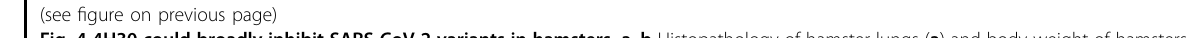
post-inoculation for H&E staining. Scale bar, 100 μ m. c 4H30 showed pre-exposure activity to signi fi cantly inhibit SARS-CoV-2 (B.1.1.63) replication. Intranasal 4H30 (0.5 mg/kg) was administered to hamsters at 24 h ( n = 4), 8 h ( n = 4), 4 h ( n = 6), or before virus challenge (4H30pre, n = 4). Intranasal H23 was administered to hamsters before the virus challenge (H23pre). Virus titers in the lungs were measured at 2 dpi. ** P < 0.01 when compared with PBS-treated hamsters (Mock). d 4H30pre could reduce syncytia formation in the bronchial epithelium of hamsters when compared with mock- treated hamsters. White circles indicated the syncytial cells with 4 or more nuclei. Scale bar, 25 μ m. e 4H30 showed post-exposure activity to inhibit SARS-CoV-2 (B.1.1.63) replication ( n = 4). 4H30 (0.5 or 0.1 mg/kg) or PBS (Mock) was intranasally inoculated into hamsters at 8 hpi. Virus titers were measured at 2 dpi. f 4H30 and remdesivir could signi fi cantly inhibit SARS-CoV-2 (B.1.617.2) replication in hamster lungs ( n = 4). Intranasal 4H30 or remdesivir (0.5 mg/kg) were administered to hamsters at 8 hpi and two more doses were given to hamsters in the following day. Virus titers were measured at 2 dpi. ** P < 0.01 when compared with Mock-treated hamsters. g 4H30 could reduce syncytia formation in the bronchial epithelium of hamsters challenged by the SARS-CoV-2 Delta variant (B.1.617.2). Representative images were taken at 2 dpi. Scale bar, 25 μ m. h – j Anti-Delta activity at 3 dpi. Infected hamsters were intranasally inoculated with PBS (Mock, n = 4), 4H30 ( n = 3), remdesivir ( n = 3) or 4H30 + Cam ( n = 3, camostat